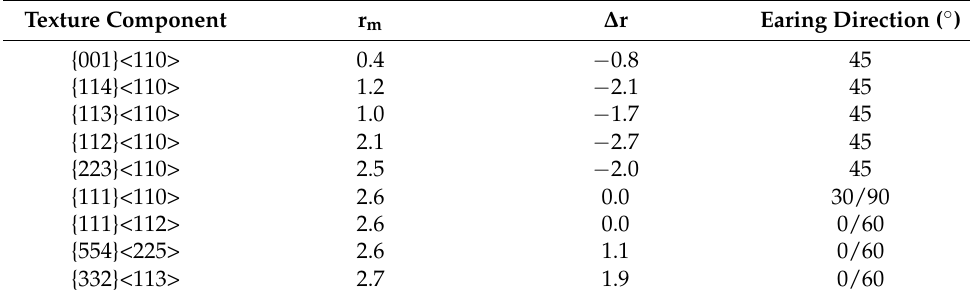
Table 4. The r m , ∆ r and earing direction for main texture